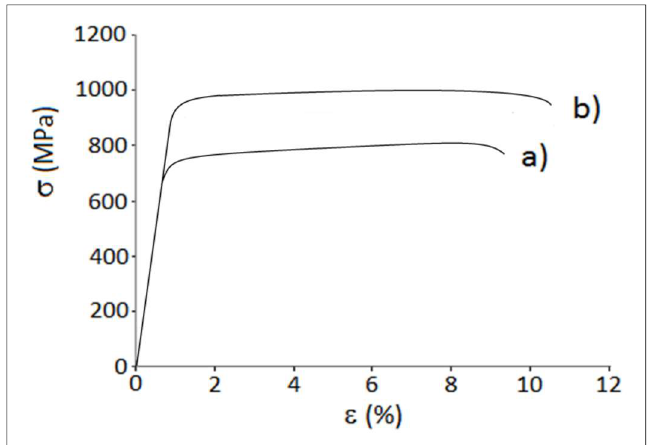
Figure 15. Stress-strain curves at room temperature for specimen A: ( a ) As-built specimen; ( b ) Smoothed specimen.